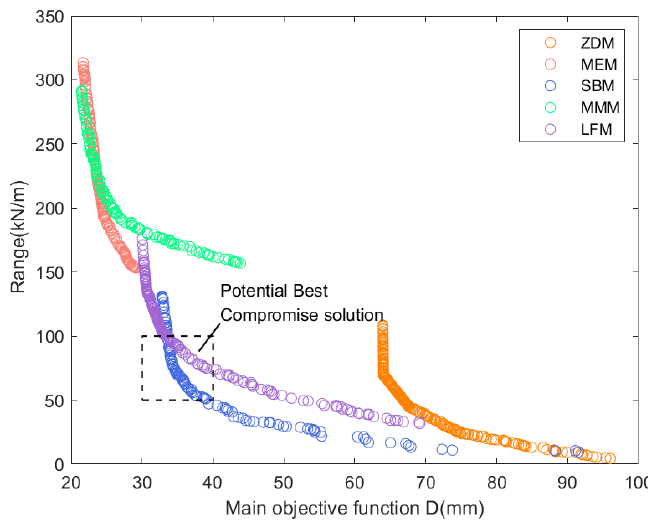
Figure 13. The global Pareto front solution sets. Fuzzy Set